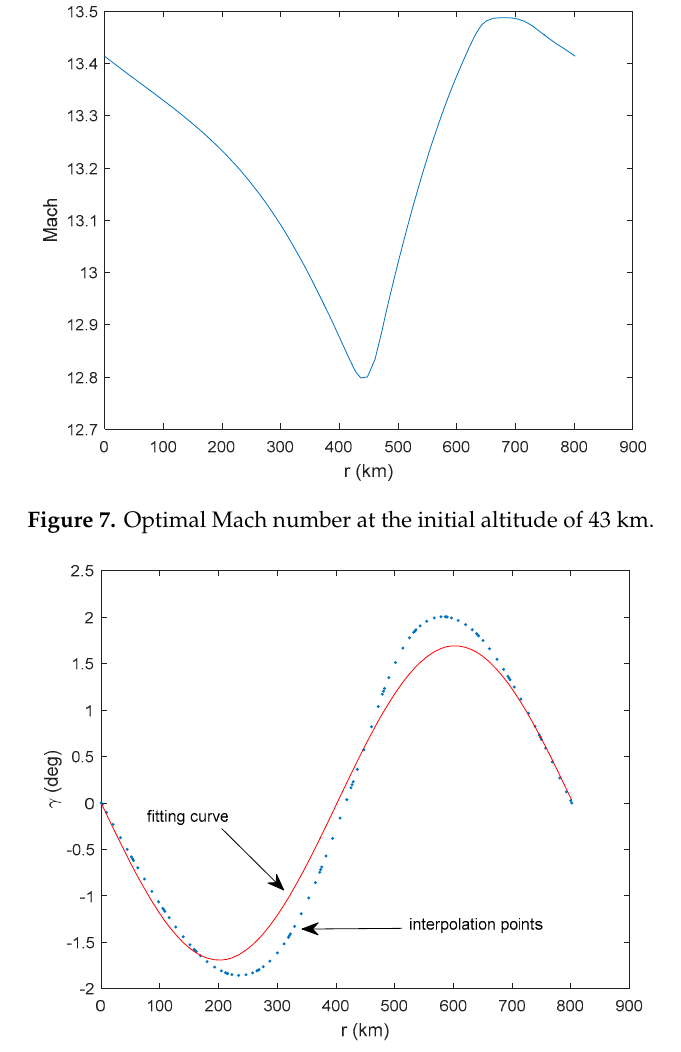
Figure 8. Optimal elevation angle at the initial altitude of 43 km.